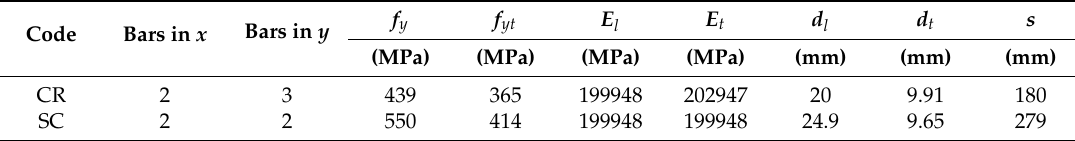
Table 2. Calibration specimens’ steel properties.